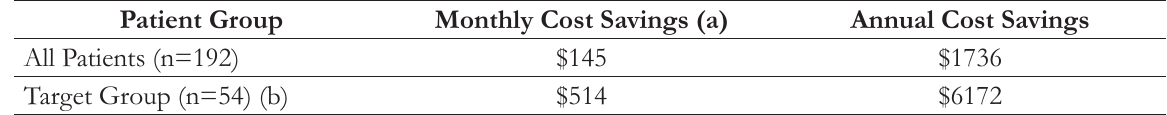
Table 2. Comparison of Monthly and Annual Cost Savings for All Patients and Target Group Patients